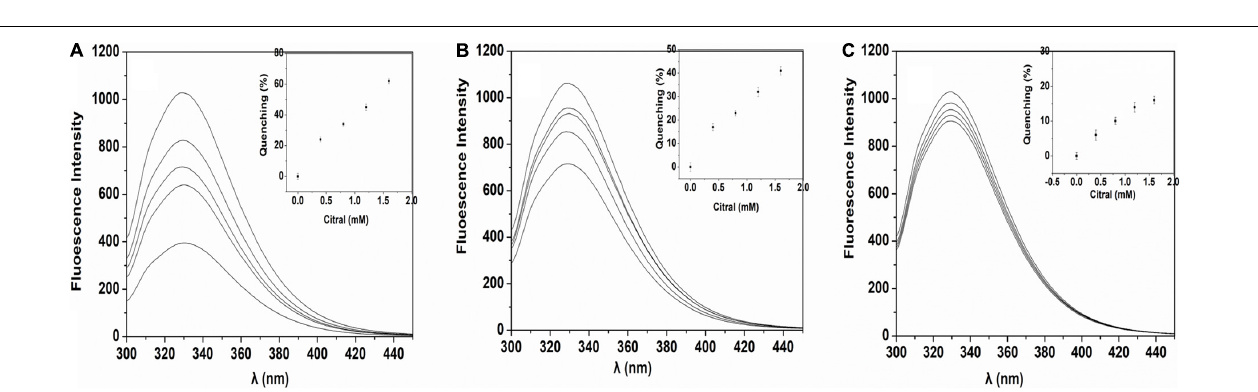
FIGURE 4 | fluorescence of SPI in citral aqueous solution. (A) L-SPI, (B) N-SPI, (C) H-SPI, the concentration of protein is 0.02% (w/v), 20 mM potassium phosphate buffer and, and citral’s primary concentration is 0.4–1.6 mmol/L.